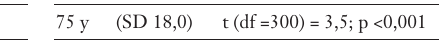
Age of the “ordinary“- suicides compared to “EXIT“-suicides be- tween 1992 and 1996.